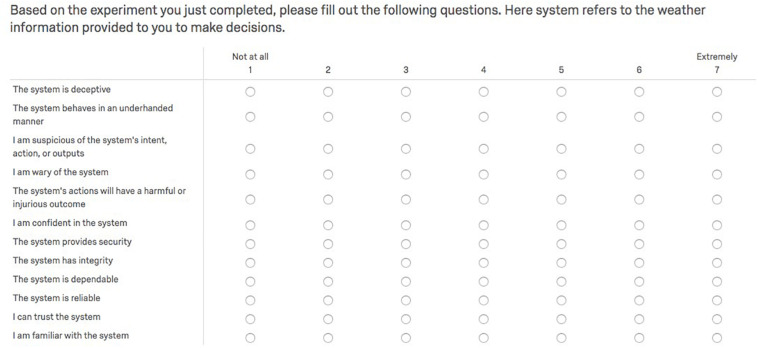
Trust in automation scale by Jian et al. (2000).